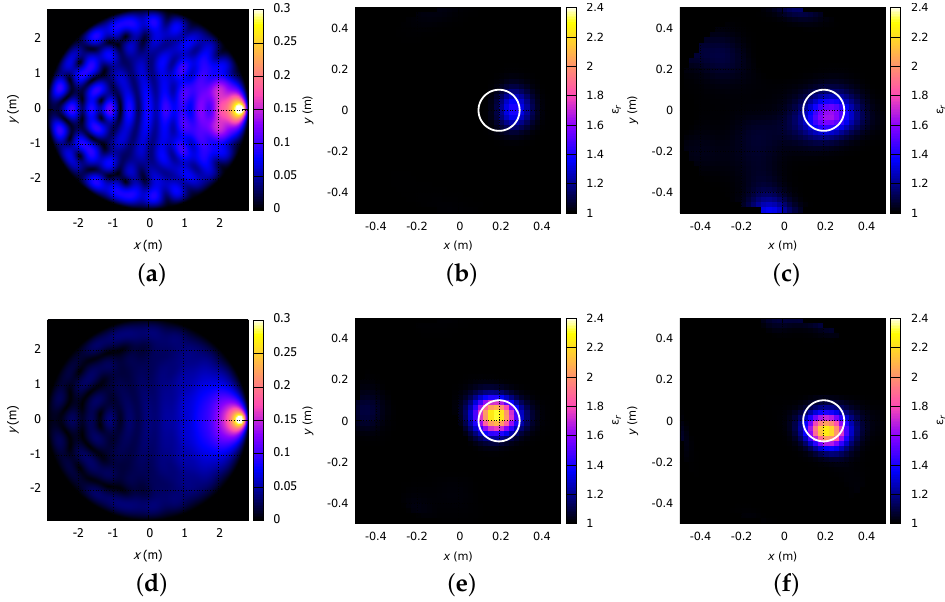
Figure 10. Examples of Green’s functions and reconstructed distributions of the relative dielectric permittivity with small conducting enclosure, a = 2.875 λ . Upper row: results with σ b = 1 mS/m: ( a ) Green’s function magnitude for a source at ( ρ s ,0 ) ; ( b ) Reconstruction with cylindrical enclosure; ( c ) Reconstruction in free space. Lower row: results with σ b = 2 mS/m: ( d ) Green’s function for point source located at ( ρ s ,0 ) ; ( e ) Reconstruction with cylindrical enclosure; ( f ) Reconstruction in free